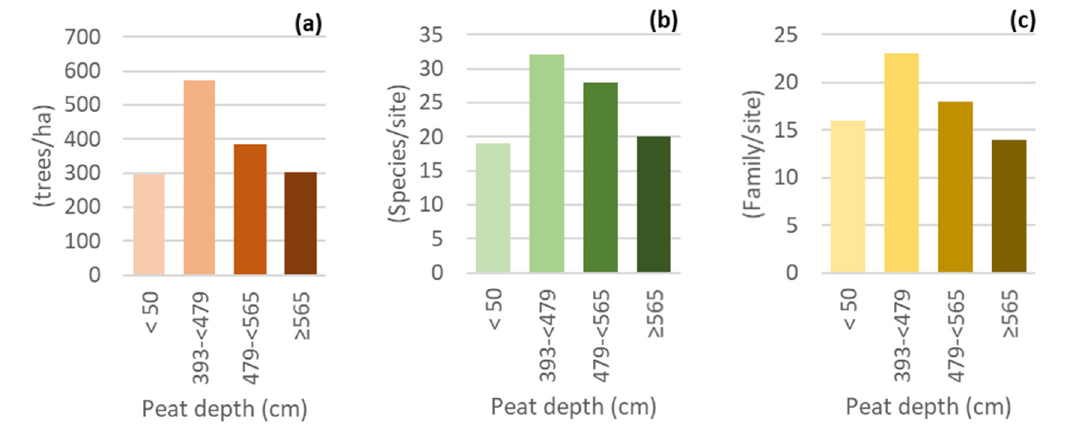
Fig. 4: Number of trees per hectare (a), species (b), and family (c) at the study sites